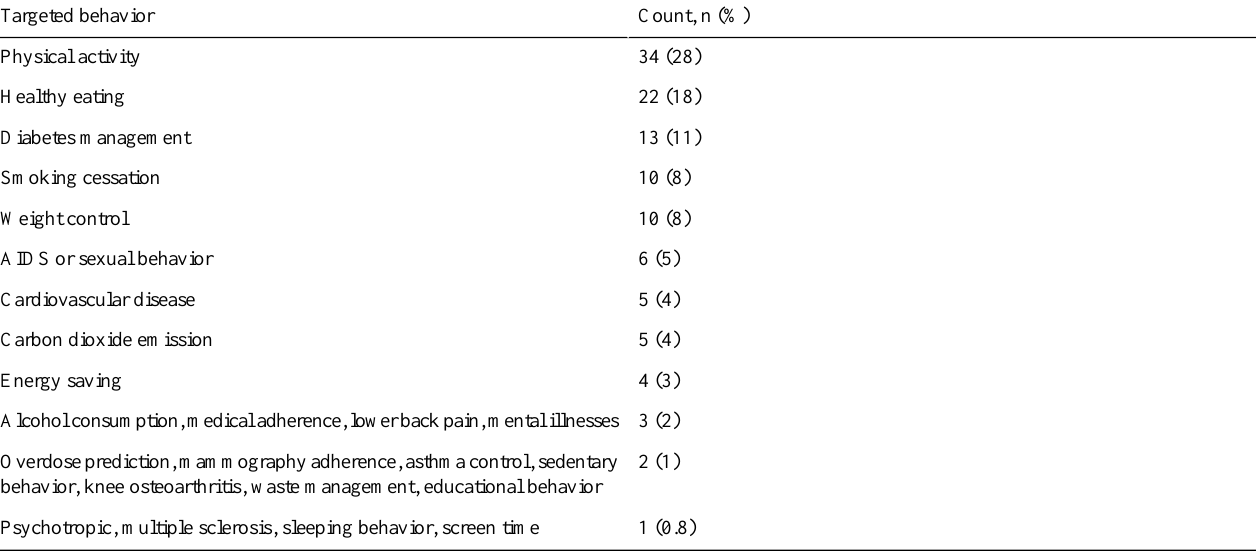
Table 7. Different targeted behavioral domains.